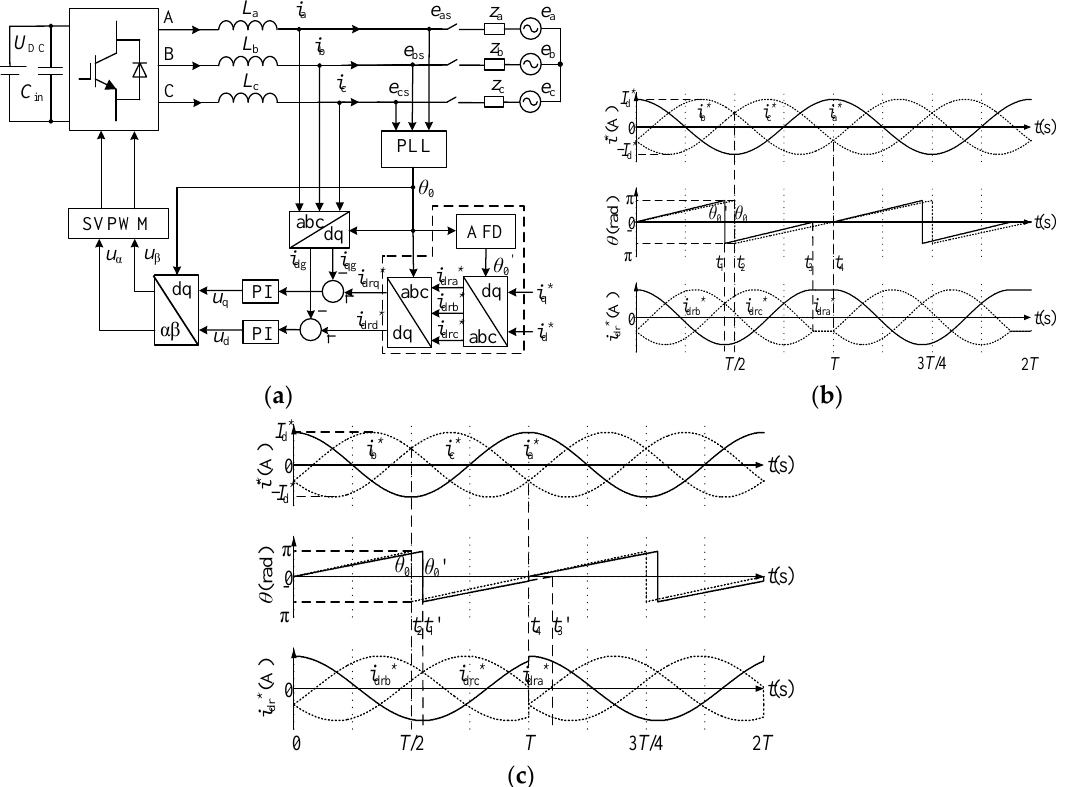
Figure 1. Principle of the three-phase active frequency drift (AFD) method. ( a ) The control diagram. ( b ) The disturbance tending to increase the current frequency. ( c ) The disturbance tending to decrease the current frequency.